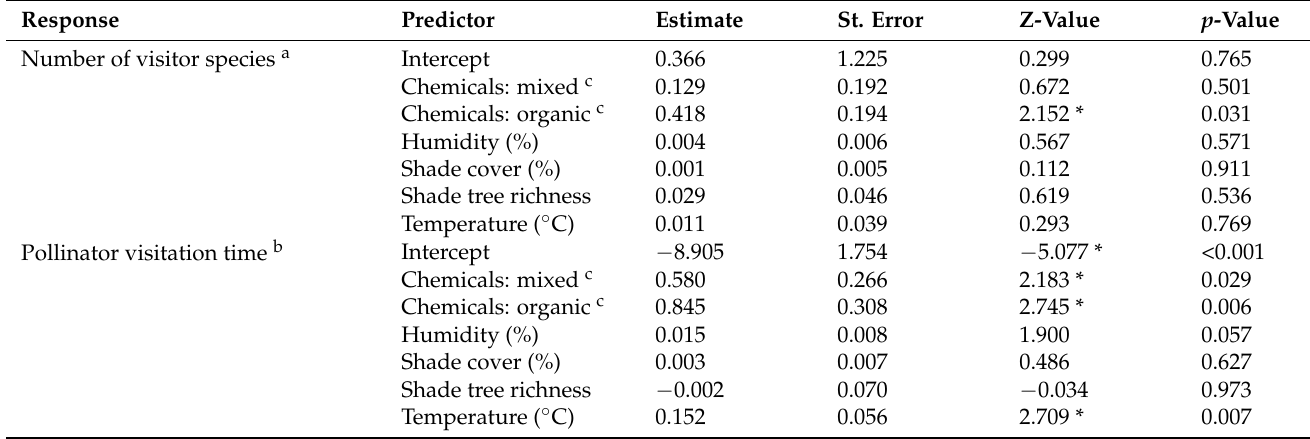
Table 2. Results of the generalized linear mixed models with number of visitor species and pollinator visitation time in coffee plants as response variables. Data are collected on 42 fields in the municipali- ties of Cipaganti and Pangauban (West Java) during four blooming seasons (July–August 2019, 2020;